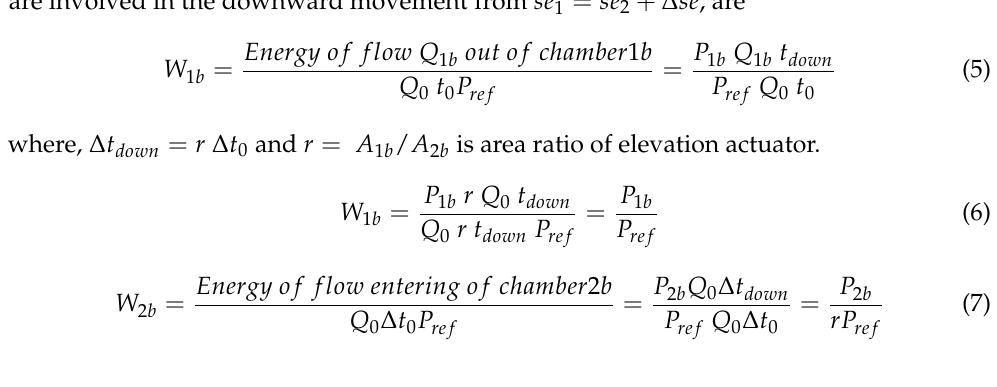
energy raising. The mass that is involved is composed of the equivalent proper mass (bucket, arm, tilt cylinder, etc.), and the nominal mass (load). M pp is the symbol that is related to the whole mechanism mass, and M N points to the nominal mass.